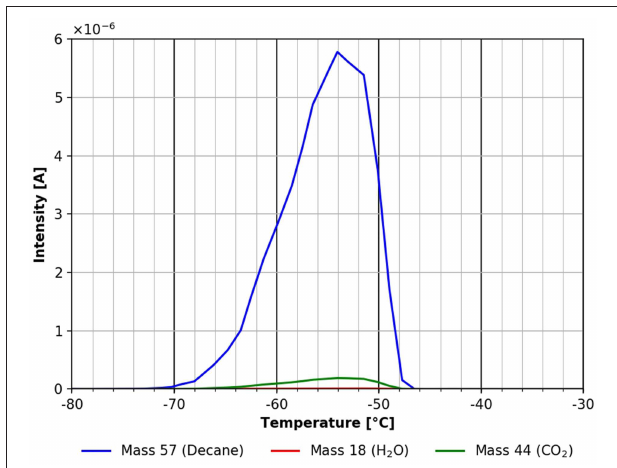
FIGURE 5 | Desorption of n-decane (mass 57, blue), carbon dioxide (mass 44, green) and water (mass 18, red) between − 80 and − 30 ◦ C.